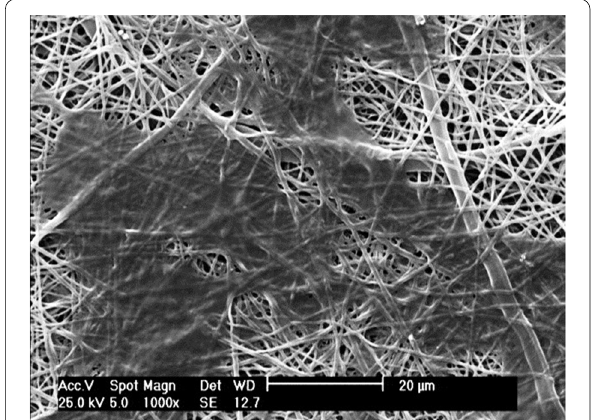
Fig. 1 Scanning electron microscopy micrographs of SSCs seeded on silk scaffolds. SEM analysis confirmed interaction and attachment of grown SSCs in silk scaffold after 5 days of culture